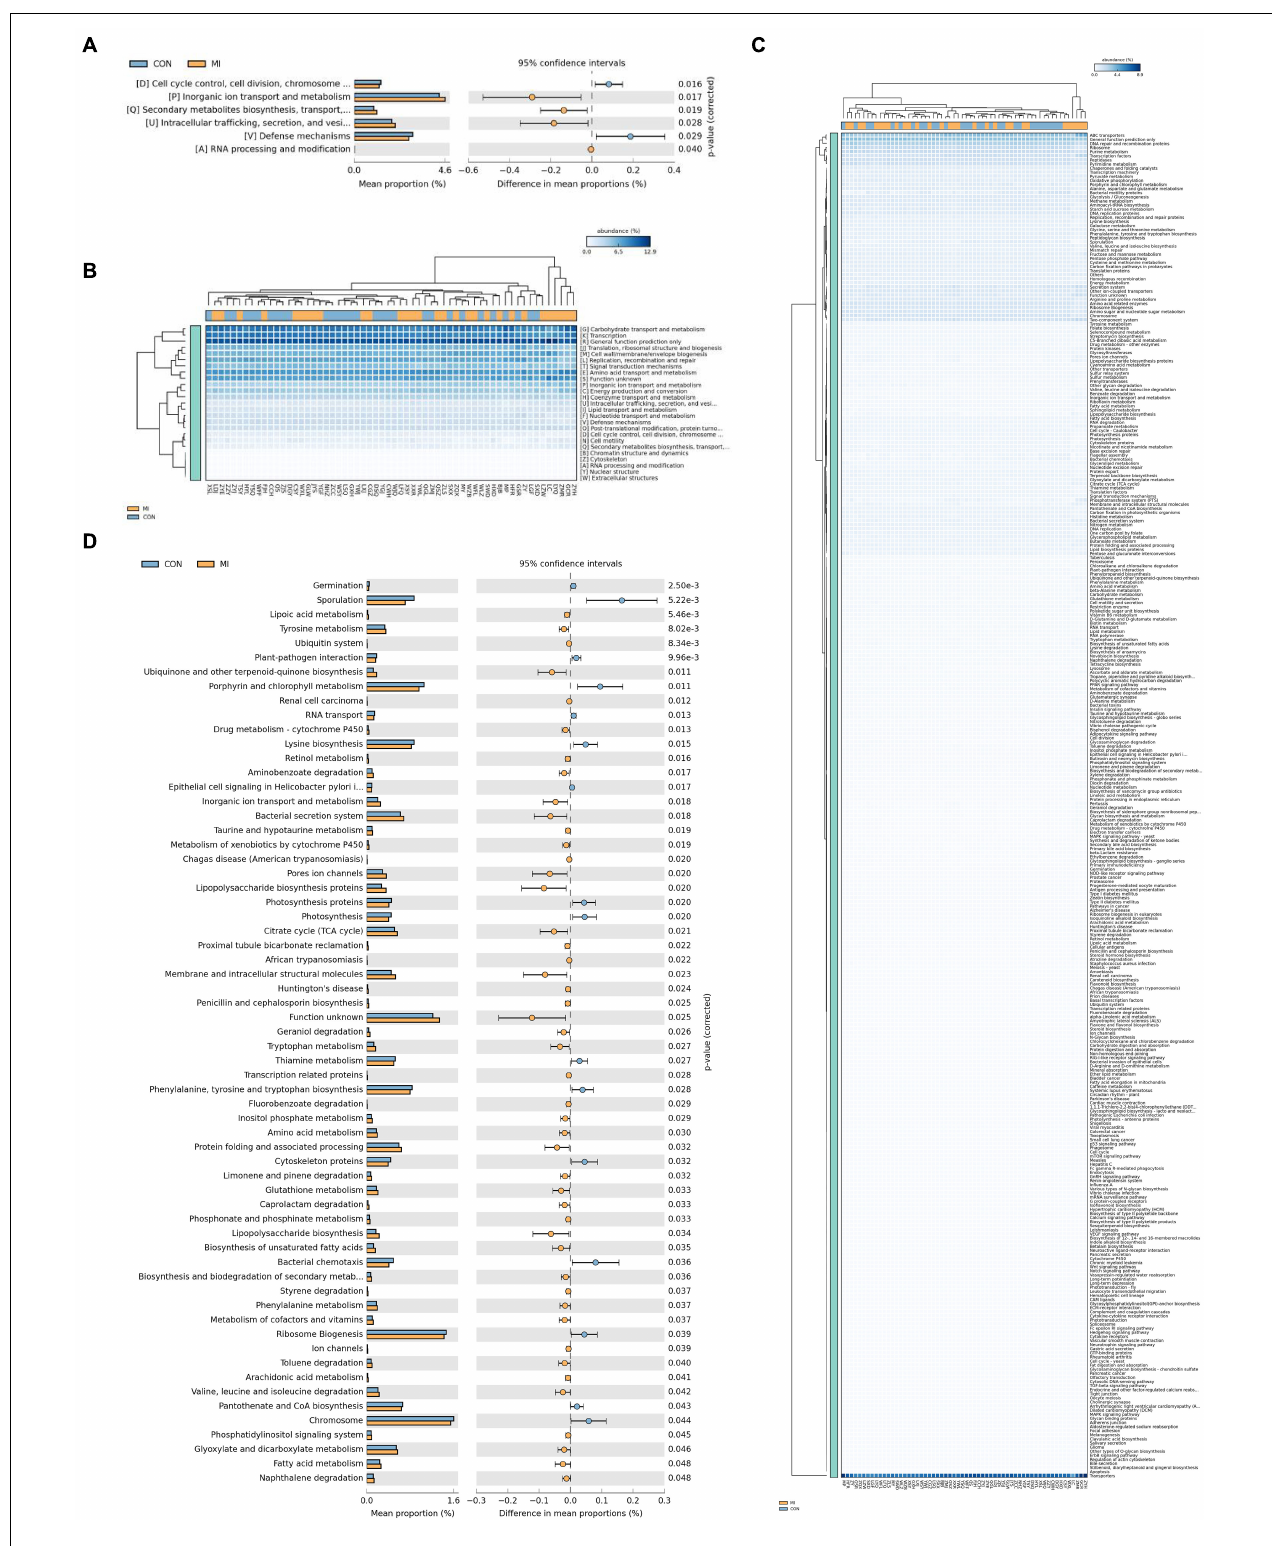
FIGURE 6 | The results of PICRUst based on closed-reference OTU to predict the abundances of functional categories COG orthologs (COs) and KEGG orthologs (KOs). (A,B) Shows the COs with significantly different abundances in the fecal microbiome between the AMI group and healthy control group; (C,D) shows the KOs with significantly different abundances in the fecal microbiome between the AMI group and healthy control group. MI, AMI group; CON, the healthy control group.